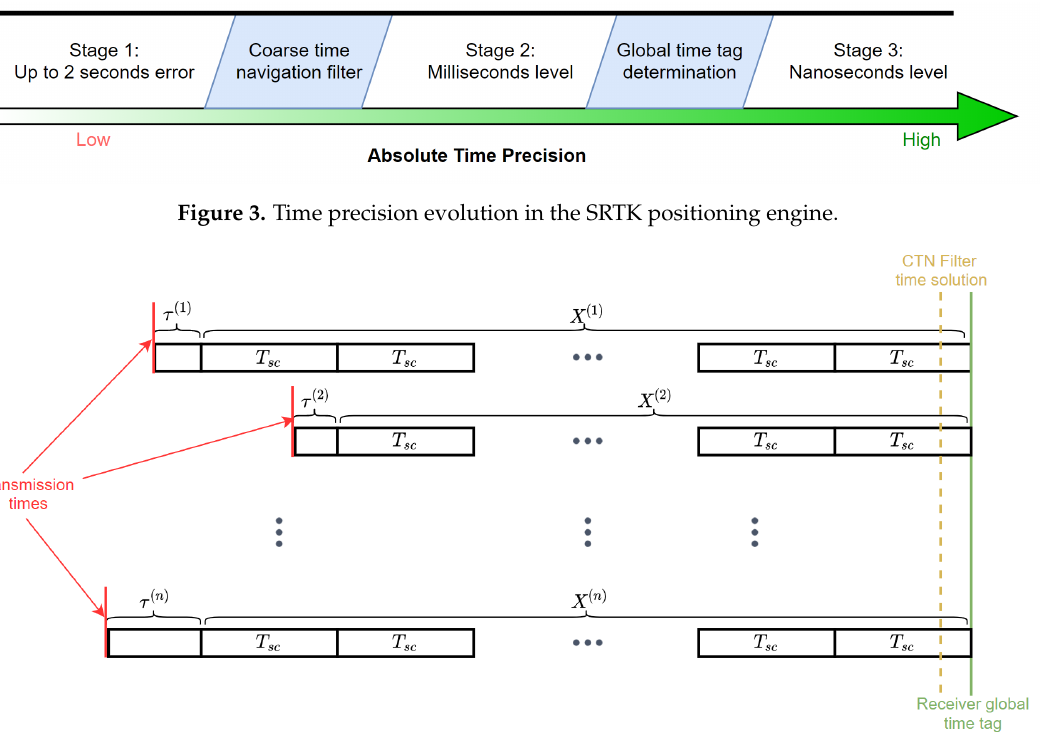
Figure 4. Relationship between the global time tag and other time